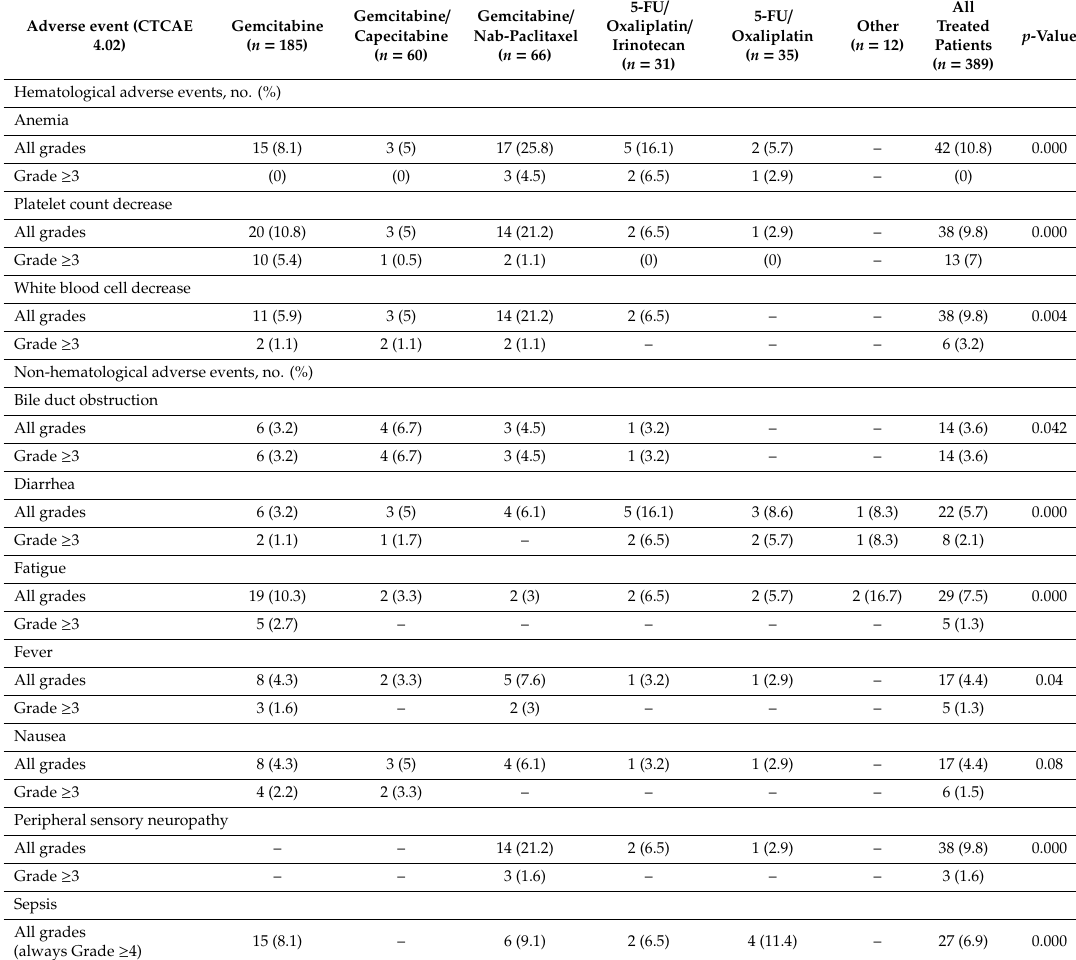
Table 3. Adverse events (all grades) accounting for ≥ 5% of total recorded events. Adverse event (CTCAE